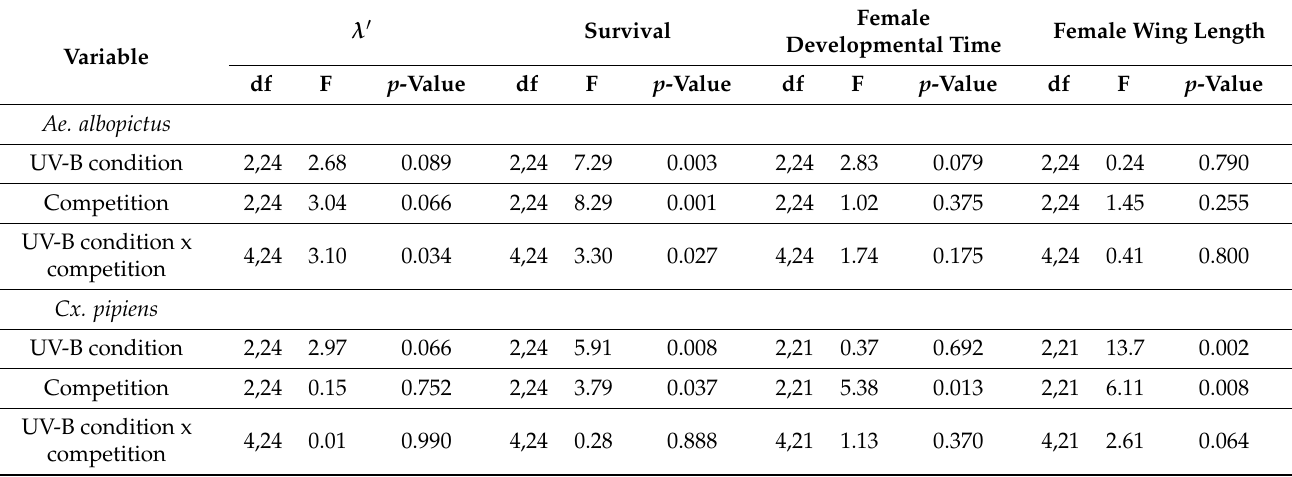
Significant ( p < 0.05) results are